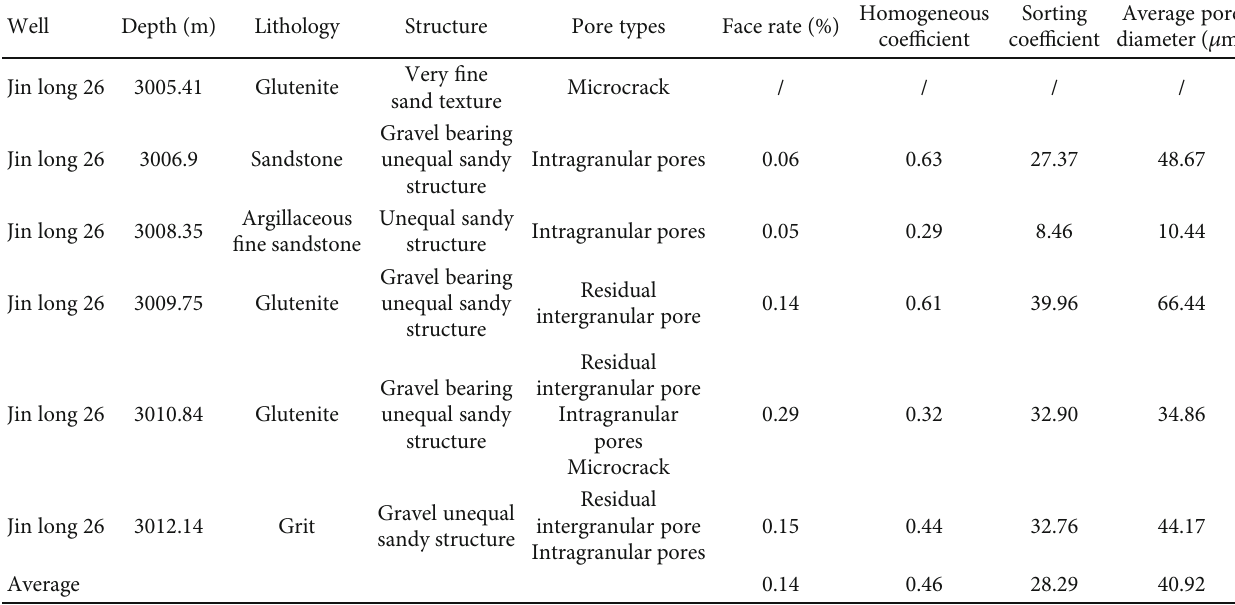
Table 2: Analysis and statistics table of thin section castings in the Wu 2 section in Ke017 well area. Well Depth